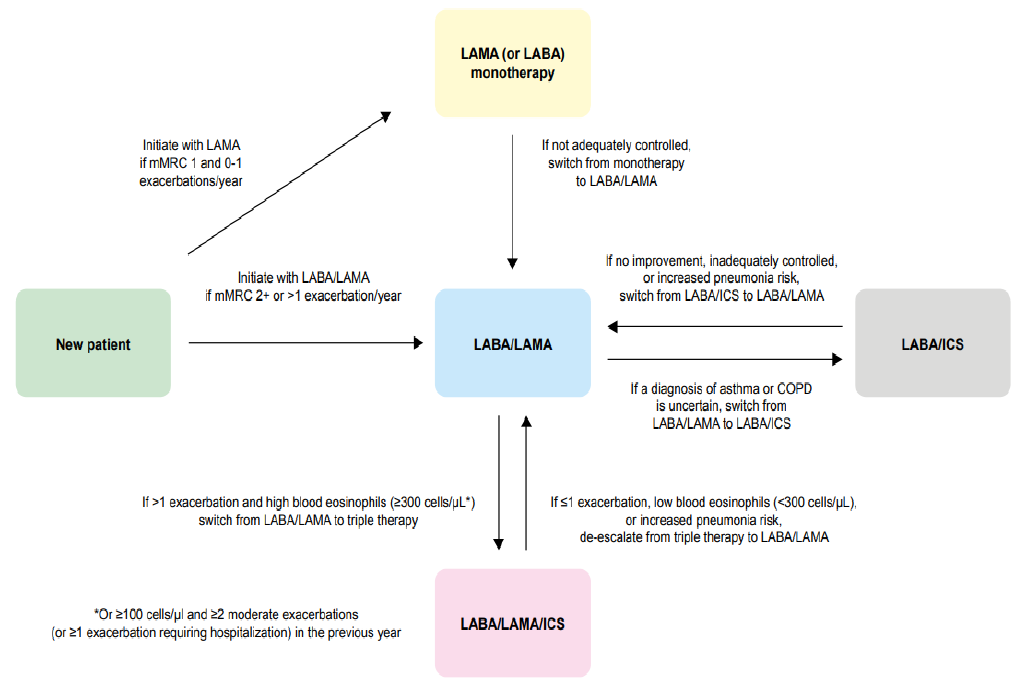
Figure 1. Algorithm to guide physicians in the treatment of COPD. * Or ≥ 100 cells/ µ L and ≥ 2 moderate exacerbations (or ≥ 1 exacerbation requiring hospitalization) in the previous year. COPD, chronic obstructive pulmonary disease; ICS, inhaled corticosteroid; LABA, long-acting β 2 -agonist; LAMA, long-acting muscarinic antagonist; mMRC, modified Medical Research